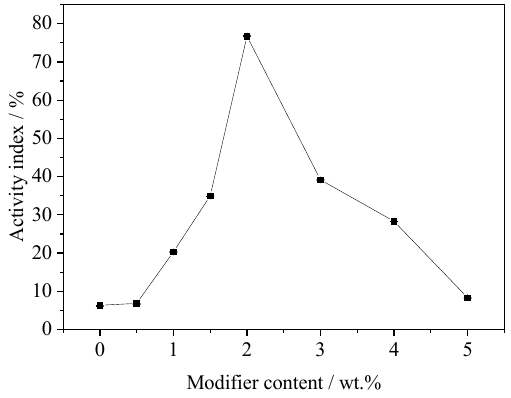
Figure 9. The change of activity index as modifier content.